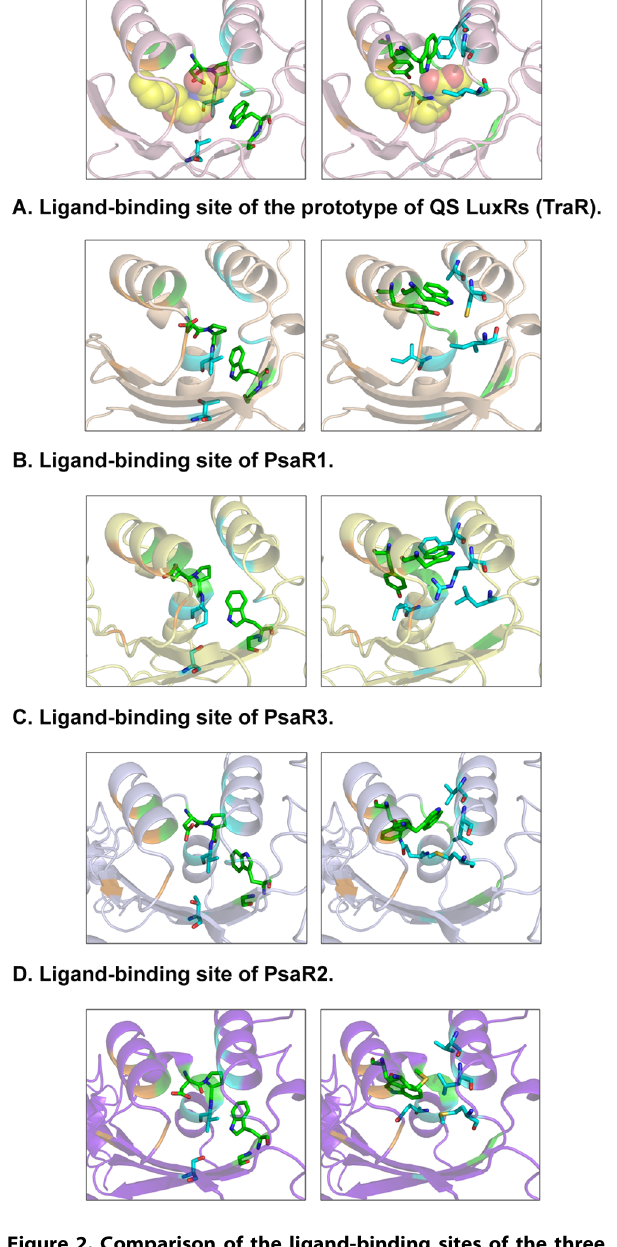
Figure 2. Comparison of the ligand-binding sites of the three Psa solos with the prototypes of QS LuxRs and PAB LuxR solos subfamily. Mapping the protein residues defining the three Clusters ( Cluster 1, Cluster 2 and Cluster 3 colored in green, cyan and in orange, respectively) showing the amino acid side chains that delineate the conserved core (left column) and the specificity patch (right column), respectively on the X-ray crystal structure of TraR in complex with OC8-HSL (PDB_ID 1H0M) [68] ( A ) and on the 3D structure-based homology models of PsaR1 ( B ), PsaR3 ( C ), PsaR2 ( D ) and OryR ( E ). The carbon, nitrogen and oxygen atoms of the OC8-HSL ligand shown in ( A ) are represented by spheres and are colored in yellow, blue and red respectively. Figures produced by Pymol